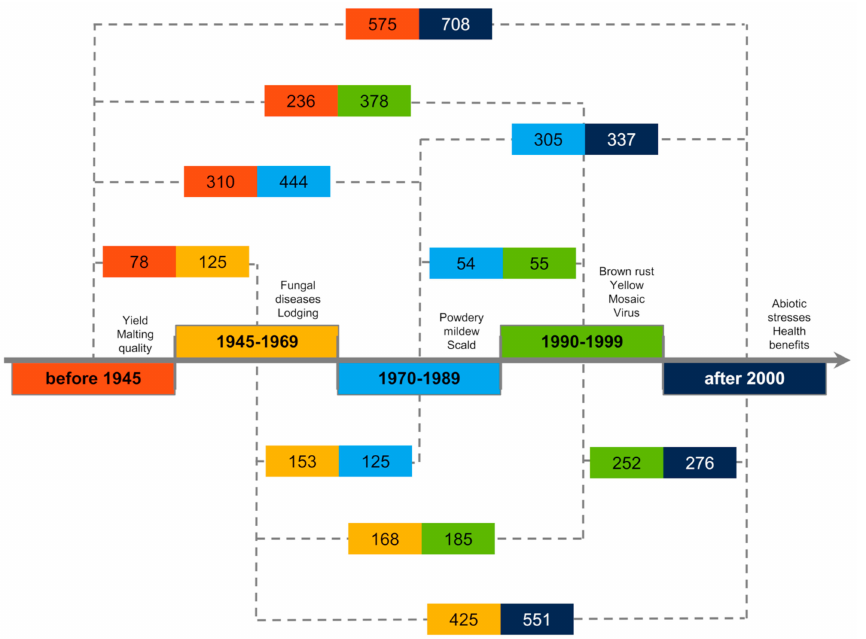
Figure 7. Summary of changes in the number of unique alleles during more than 120 years of breeding and cultivation of spring barley in Poland. Colors indicate groups and dashed lines connect compared periods. Above the axis, information about the new breeding objectives is